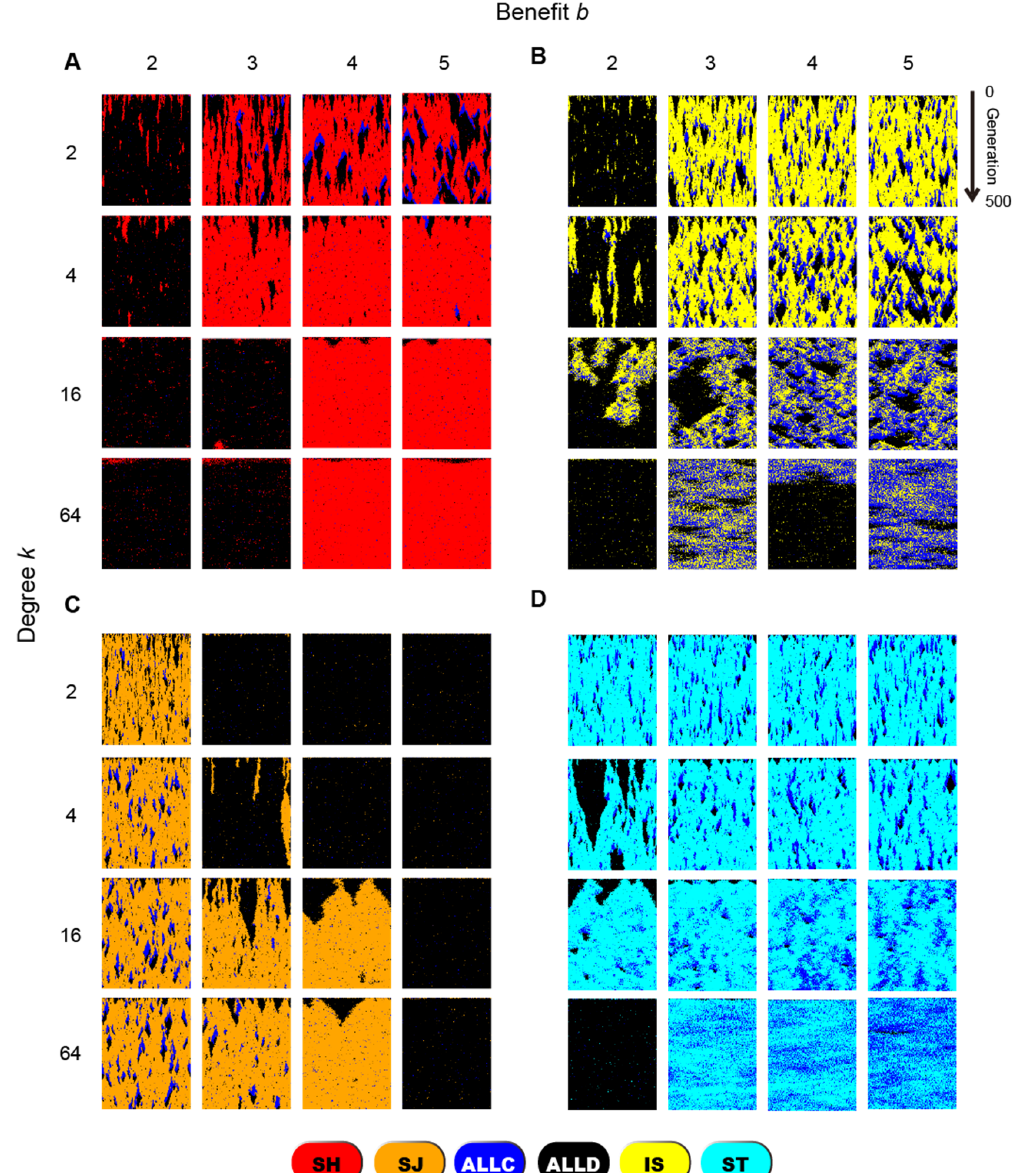
Figure 5. Evolution of spatial patterns of indirect reciprocity on regular ring lattices with direct observation and private assessment errors. ( A ) Shunning (SH) (red color) is likely to take over the population for the specific parameters; yet, the cooperation rate is low; ( C ) stern judging (SJ) (orange color) is less likely to thrive here than with the public assessment error, as shown in Figure 4C; ( B ) image scoring (IS) (yellow color) is most likely to lead to a three ‐ strategy coexistence similar to what is shown in Figure 4B; ( D ) simple standing (ST) (cyan color) is most likely to maintain a state exclusively mixed of DISCs and ALLCs similar to what is shown in Figure 4D. The results from IS and ST remain qualitatively unchanged regarding the kind of assessment error. Parameters: g = 500 generations, h = 50 periods, error rates p = q = 0.01 (both for implementation and private assessment errors), selection intensity s = 1, mutation rate m = 0.01, and c = 1.